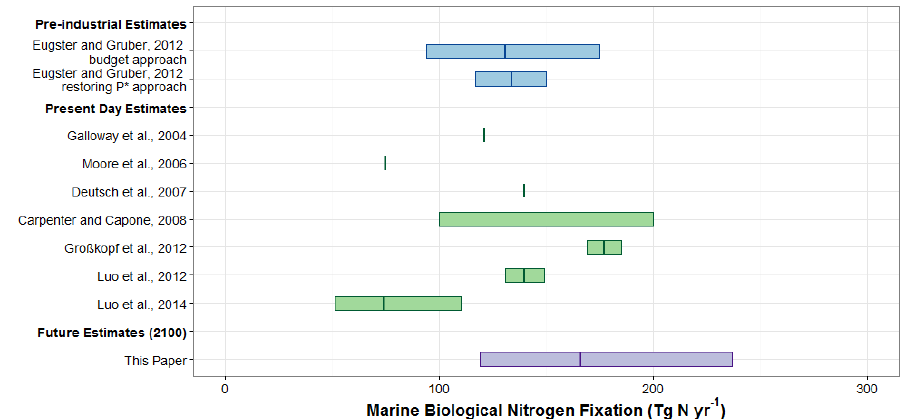
Figure 2. Summary of pre-industrial (blue), present (green), and future (purple) estimates of marine biological nitrogen fixation (BNF). Estimate from Carpenter and Capone (2008) represents their summary of the range presented in the literature, and includes no midpoint. Luo et al. (2012) values are arithmetic mean ± standard error, so range limits may not be directly comparable to other estimate range limits. Estimates for fixation by Trichodesmium alone by Barcelos e Ramos et al. (2007) (60–85TgNyr − 1 in 2005, 90–128TgNyr − 1 by year 2100) and Hutchins et al. (2009) (80–100TgNyr − 1 by 2100) are included in text but not presented in figure because the estimates in the figure are for total marine